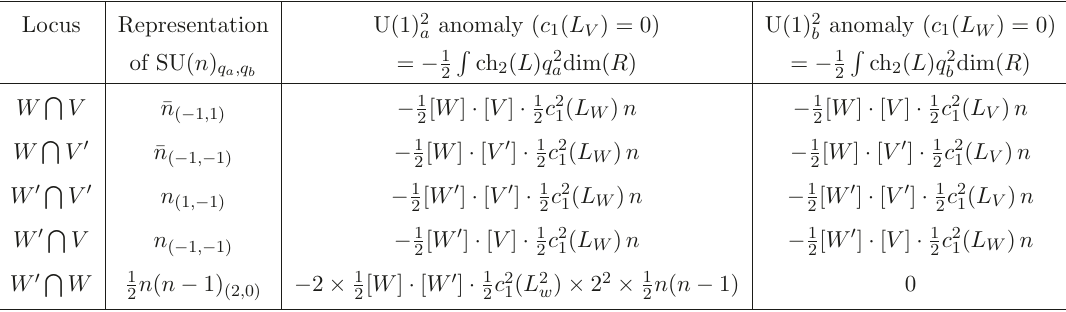
Table 2 . Charged chiral matter from the 7-7 string sector and its anomaly